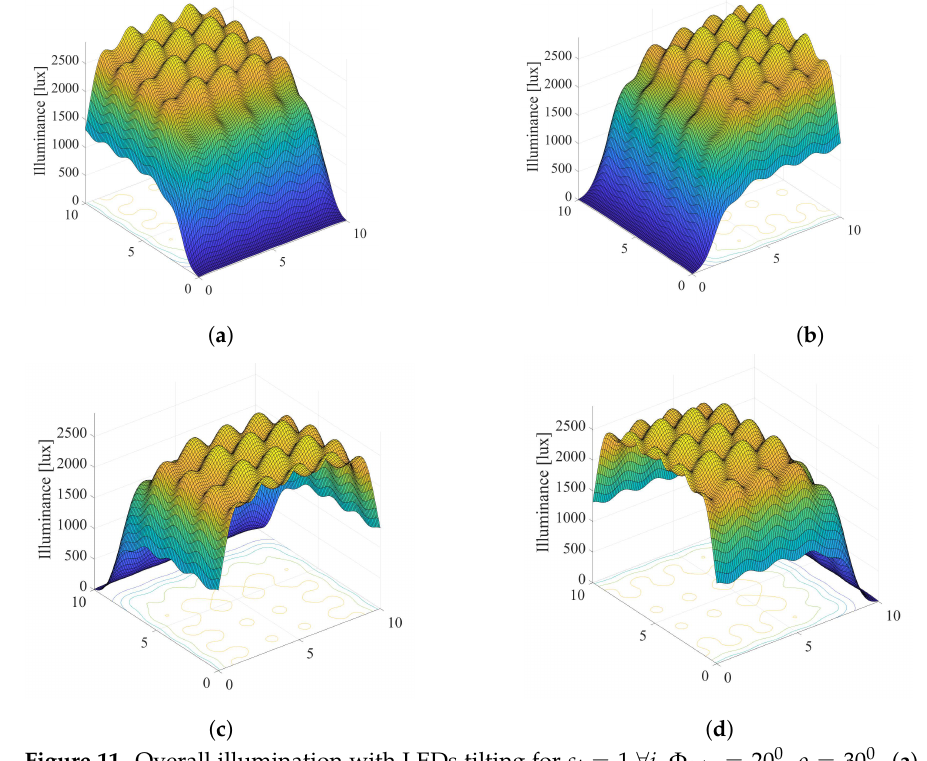
Figure 11. Overall illumination with LEDs tilting for s i = 1 ∀ i , Φ 1/2 = 20 0 , ρ = 30 0 . ( a ) ρ = 30 0 ,